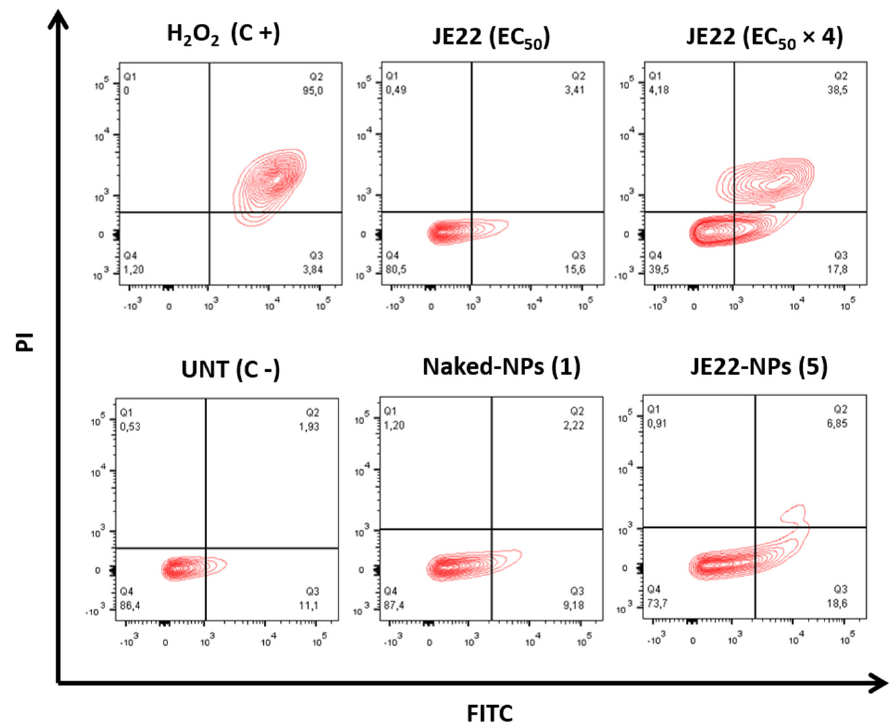
Figure 9. Effect of JE22 and JE22-NPs ( 5 ) on MDA-MB-231 cell apoptosis. Representative scatter plots of PI ( y -axis) versus FITC ( x -axis) of cells after treatment with JE22-NPs ( 5 ) (20,000 NPs/cell), JE22 (EC 50 and 4 × EC 50 ), and Naked-NPs ( 1 ) (20,000 NPs/cell) for 24 h. Number of nanoparticles was determined by spectrophotometric analysis (see Figure S7). The cells were analyzed after double staining with Annexin V-FITC/PI by flow cytometry. Dot plots of H 2 O 2 (2 mM, treatment of 4 h) and untreated cells were represented as the positive and negative control, respectively. Q1-4 quadrants represent necrotic (Annexin V-FITC-, PI+), late (Annexin V-FITC+, PI+), and early (Annexin V-FITC+, PI-) apoptotic and viable (Annexin V-FITC-, PI-) cells,